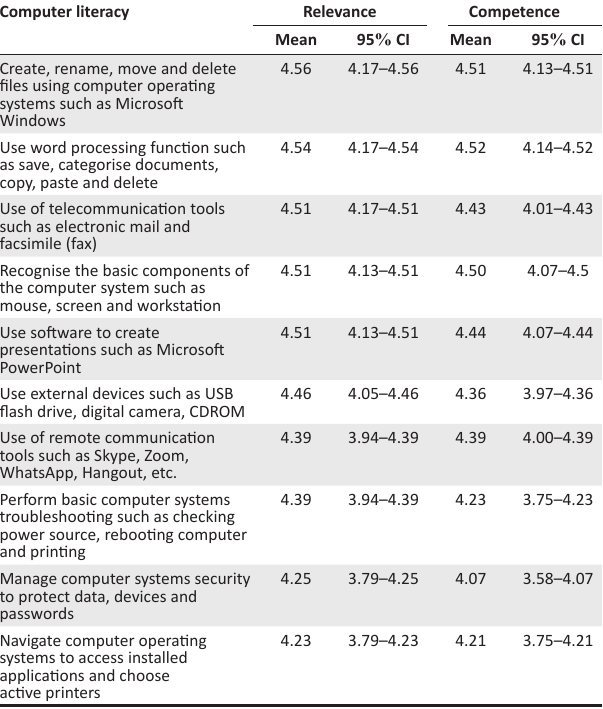
TABLE 1: Computer literacy skills.